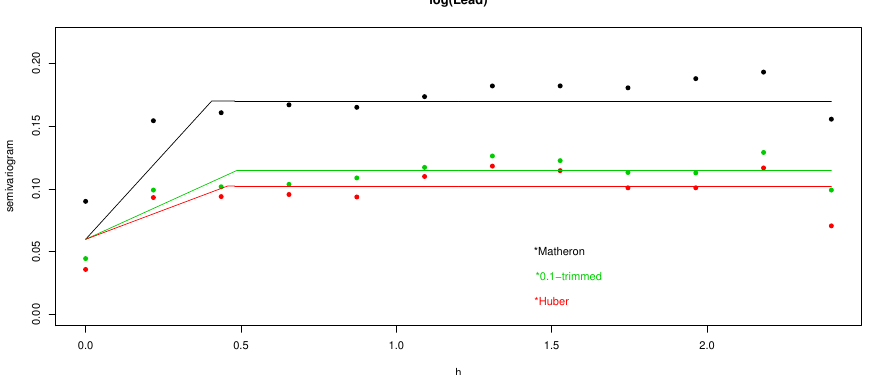
Figure 7. Classical (black) and robust (green and red) variogram estimations for the logarithm of lead and their linearized variograms of Example